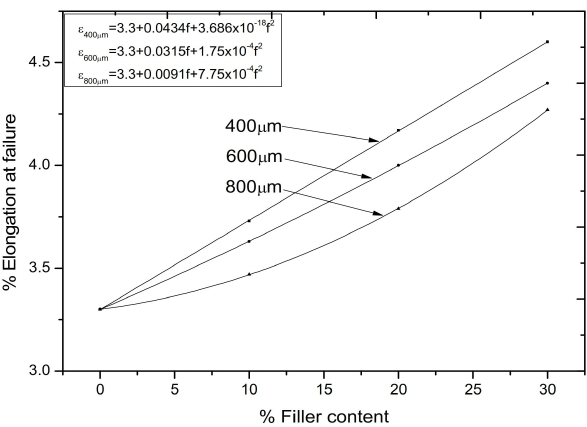
Figure 4: Variation of tensile strength with RH content and particle size [27]